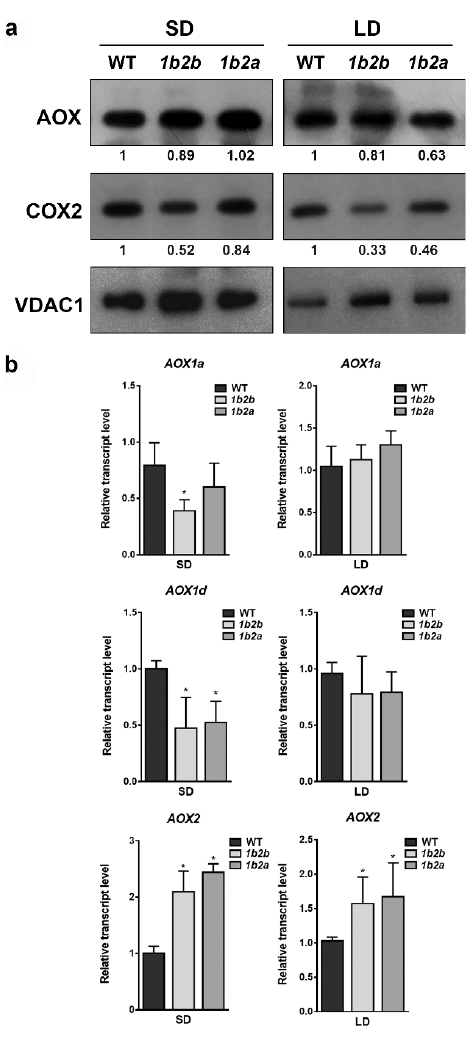
Figure 1. AOX and COX2 levels in leaves of wild-type (WT) and cytc mutants ( 1b2a and 1b2b ) grown in short-day (SD) and long-day (LD) photoperiods. ( a ) Western blot analysis of AOX and COX2 protein levels from total leaf protein extracts. The intensities of the signals from AOX and COX2 were normalized to those from porin (VDAC) and are expressed relative to WT levels. The normalized intensity values shown are averages of two independent blots. ( b ) Transcript levels for AOX1a , AOX1d , and AOX2 genes evaluated in the same plants as in ( a ). Bars represent the means ± SD of three biological replicates. Asterisks indicate significant differences ( p < 0.05) with the WT plants of the same stage according to LSD Fisher tests. The relative levels of transcripts encoding the AOX protein were also compared between WT and cytc mutants grown under both photoperiods (Figure 1b). Under SD, the transcript levels of AOX1a (only in 1a2b line) and AOX1d were significantly lower in cytc mutants than in WT. On the contrary, the transcript levels of AOX2 were higher in cytc mutants than in WT grown under SD. Under LD, the transcript levels of AOX2 were also higher in cytc mutants, while the levels of AOX1a and AOX1d were not significantly different from